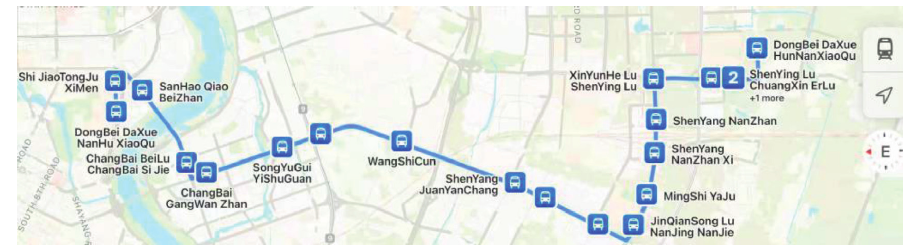
Figure 3: A bidirectional public bus route in Shenyang (map from Baidu). Table 2: Timetable of the electric bus